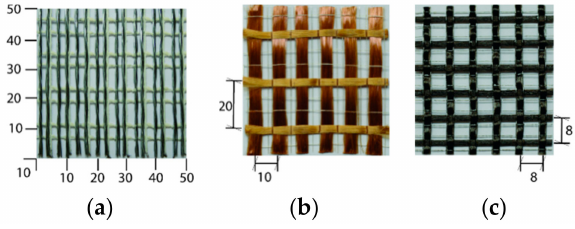
Figure 2. FRCM textiles: ( a ) SRG, ( b ) PBO and ( c ) basalt (dimensions are in